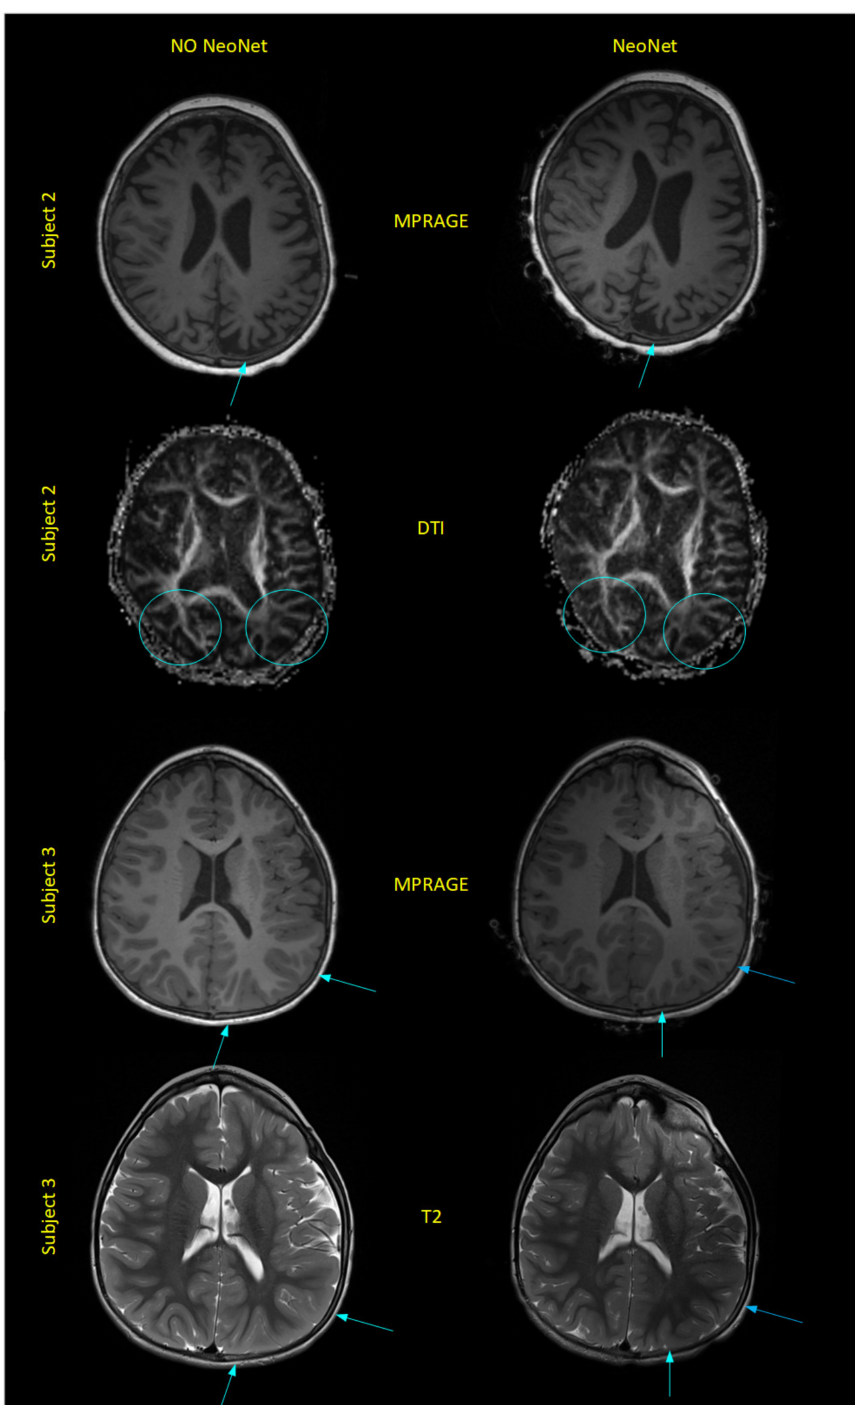
Figure 7. MRI data with NoNet ( left ) vs. NeoNet ( right ). Both the NoNet ( left ) and NeoNet ( right ) enabled the pediatric neuroradiologist P.E.G. to clinically identify the lesions. Subject 2: Comparison of T1 magnetization prepared rapid gradient echo (MPRAGE) and diffusion tensor imaging (DTI) sequences of a five year old female with left-side parietal atrophy (indicated by arrows on the MPRAGE and circles on the DTI that point to the differences in the white matter tracts between the left and the right hemisphere). Subject 3: Comparison of MPRAGE and T2 sequences of a five year old male with left-side tuberous malformations (arrow) showed a similar image quality of NoNet ( left ) and with NeoNet ( right